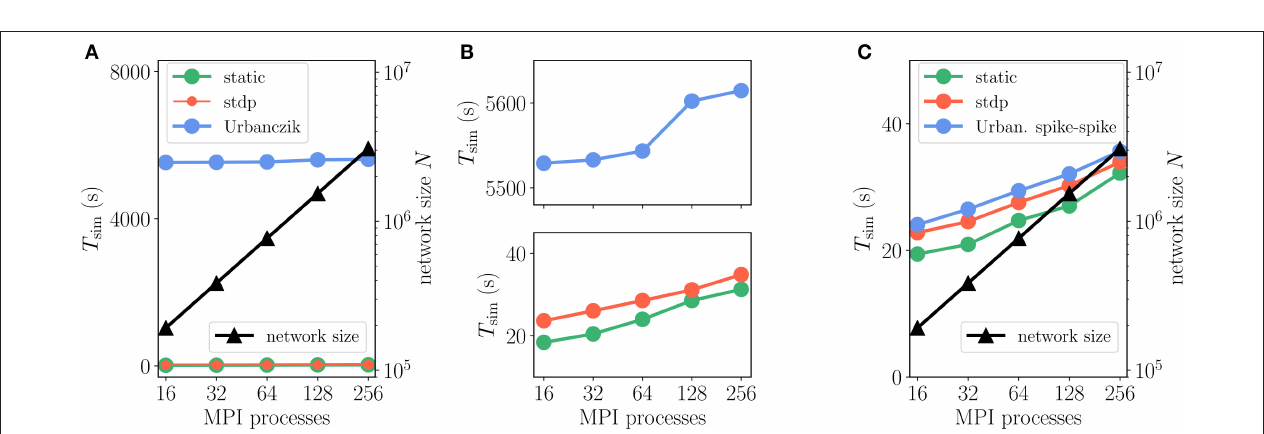
FIGURE 12 | Scaling of simulation times T sim with network size for 2 s of biological time: Urbanczik-Senn plasticity. Same weak scaling as in Figure 10 . (A) Event-driven Urbanczik-Senn rule (blue) compared to static (green) and STDP synapse (red). On the scale of the vertical axis the red curve (STDP synapses) falls on top of the green curve (static synapses), indicated by finer line width and marker size of the former. (B) Same simulation time data as in (A) but with a smaller range on the vertical axis. Upper panel: enlargement of Urbanczik-Senn data. Lower panel: enlargement of data for static and STDP synapses. (C) Spike-spike version of the Urbanczik-Senn rule compared to static and STDP synapse. Network and simulation parameters as in Supplementary Table 5 with in-degree K = 5,000. For all simulations each compute node runs one MPI process with 24 threads.